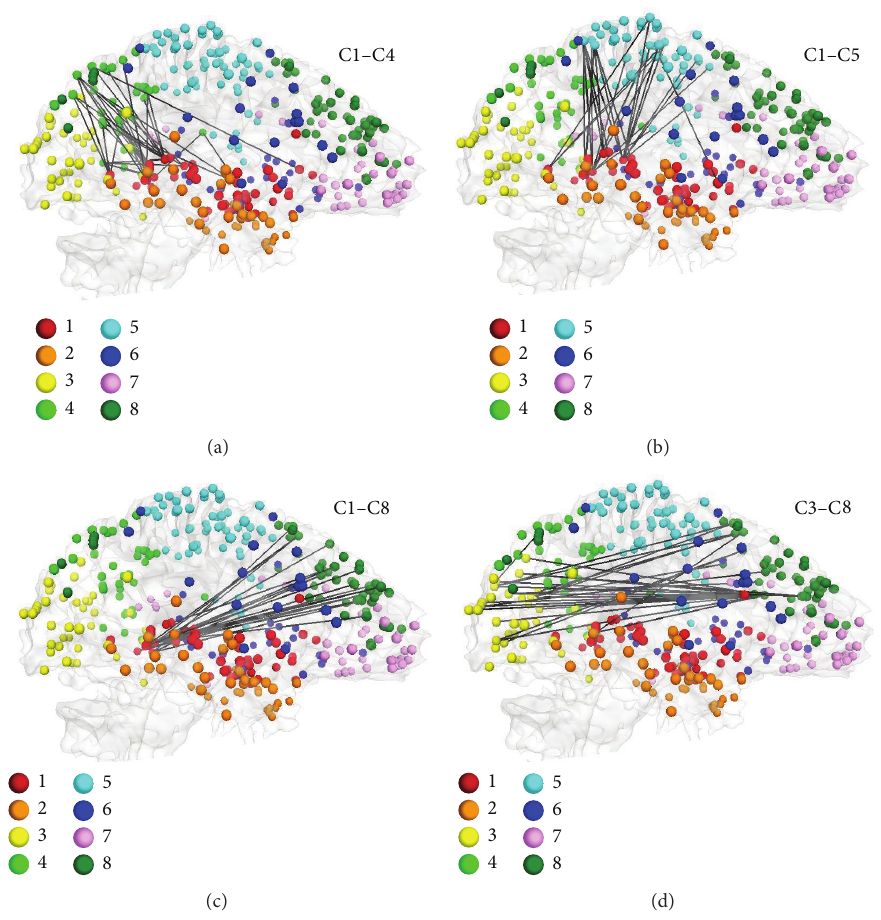
Figure 8: Categorization of affected functional connectivity using the multiview cluster-wise cluster method. (a)–(c) show the connectomic signatures involved in the interaction between cluster number 1 (C1) and clusters numbers 4 (C4), 5 (C5), and 8 (C8), respectively. These interactions represented the important role of the PCC as the central hub of the brain and its interactions with association brain areas as compensatory effects after brain injury. (d) reveals the interaction between the occipital lobe, cluster number 3 (C3), and the frontal lobe, cluster number 8